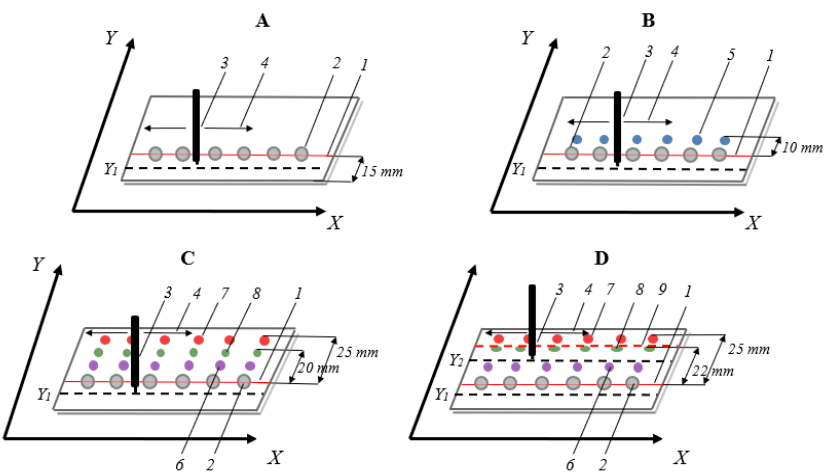
Figure 8. Stages of biological sample preparation by solvent front position extraction (details in the text). The dashed lines mark the path of the pipette delivering the eluent. 1—starting line, 2—starting spots of the samples, 3—pipette delivering the eluent, 4—the direction of movement of the pipette, 5—substances eluted from the plasma zone, 6—matrix components of higher retention than the substances of interest, 7—matrix components of lower retention than the substances of interest, 8—the zone of substances of interest (including the IS), 9—a line indicating the appropriate (final) front of the mobile phase. ( A )—initial position of the pipette before chromatogram development; ( B )—first, short distance elution of the test substances from starting spot; ( C )—second elution of the substances to reach R f values close to 0.5; ( D )—third elution to reach the solvent front position of the investigated substances. For details, see the text.